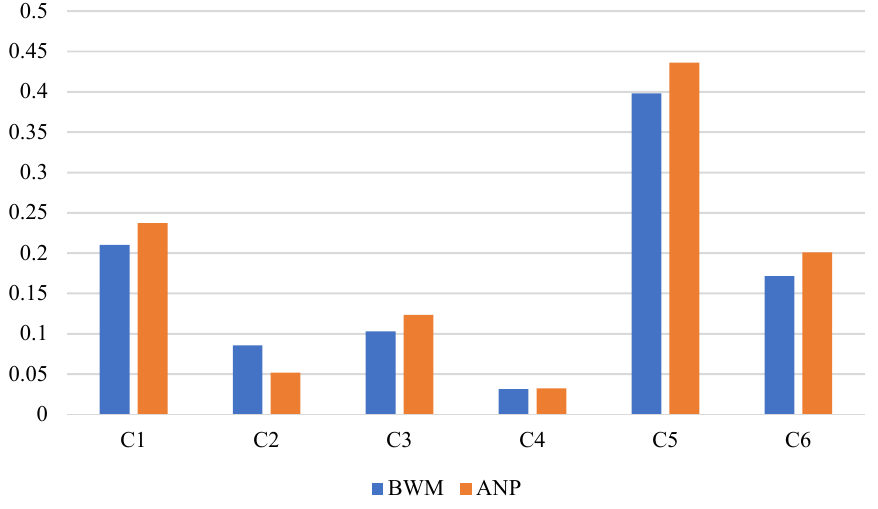
Figure 2. BWM and ANP results comparison.